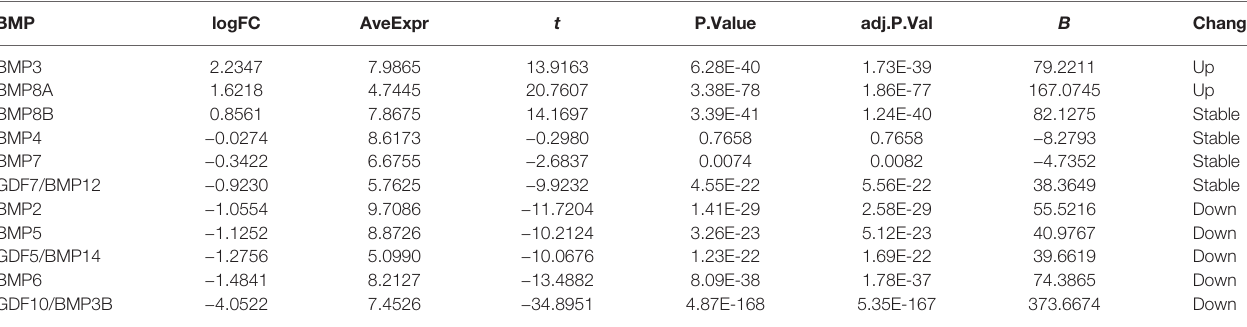
TABLE 1 | The differential expression of 11 BMPs in lung